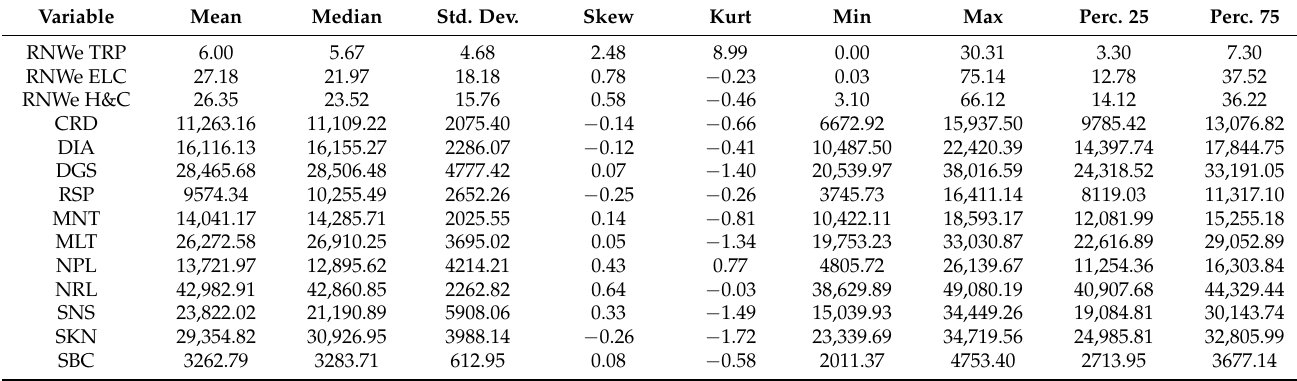
on the basis of this test, it was not possible to identify the countries between which the differences were found and between which no differences were found. Thus, Appendix A shows the average values in the classification of countries, which may provide a closer look at the results. Differences within the classification of years were significant only in two cases (RNWe TRP = 53.52 †; DIA = 23.30 ***). These results indicated that when examining the relationships between the indicators, it was appropriate to use methods that are able to take the structure of countries into account. Table 1. Descriptive analysis of renewable energy (%) and disease prevalence (per population of 100,000). Variable Mean